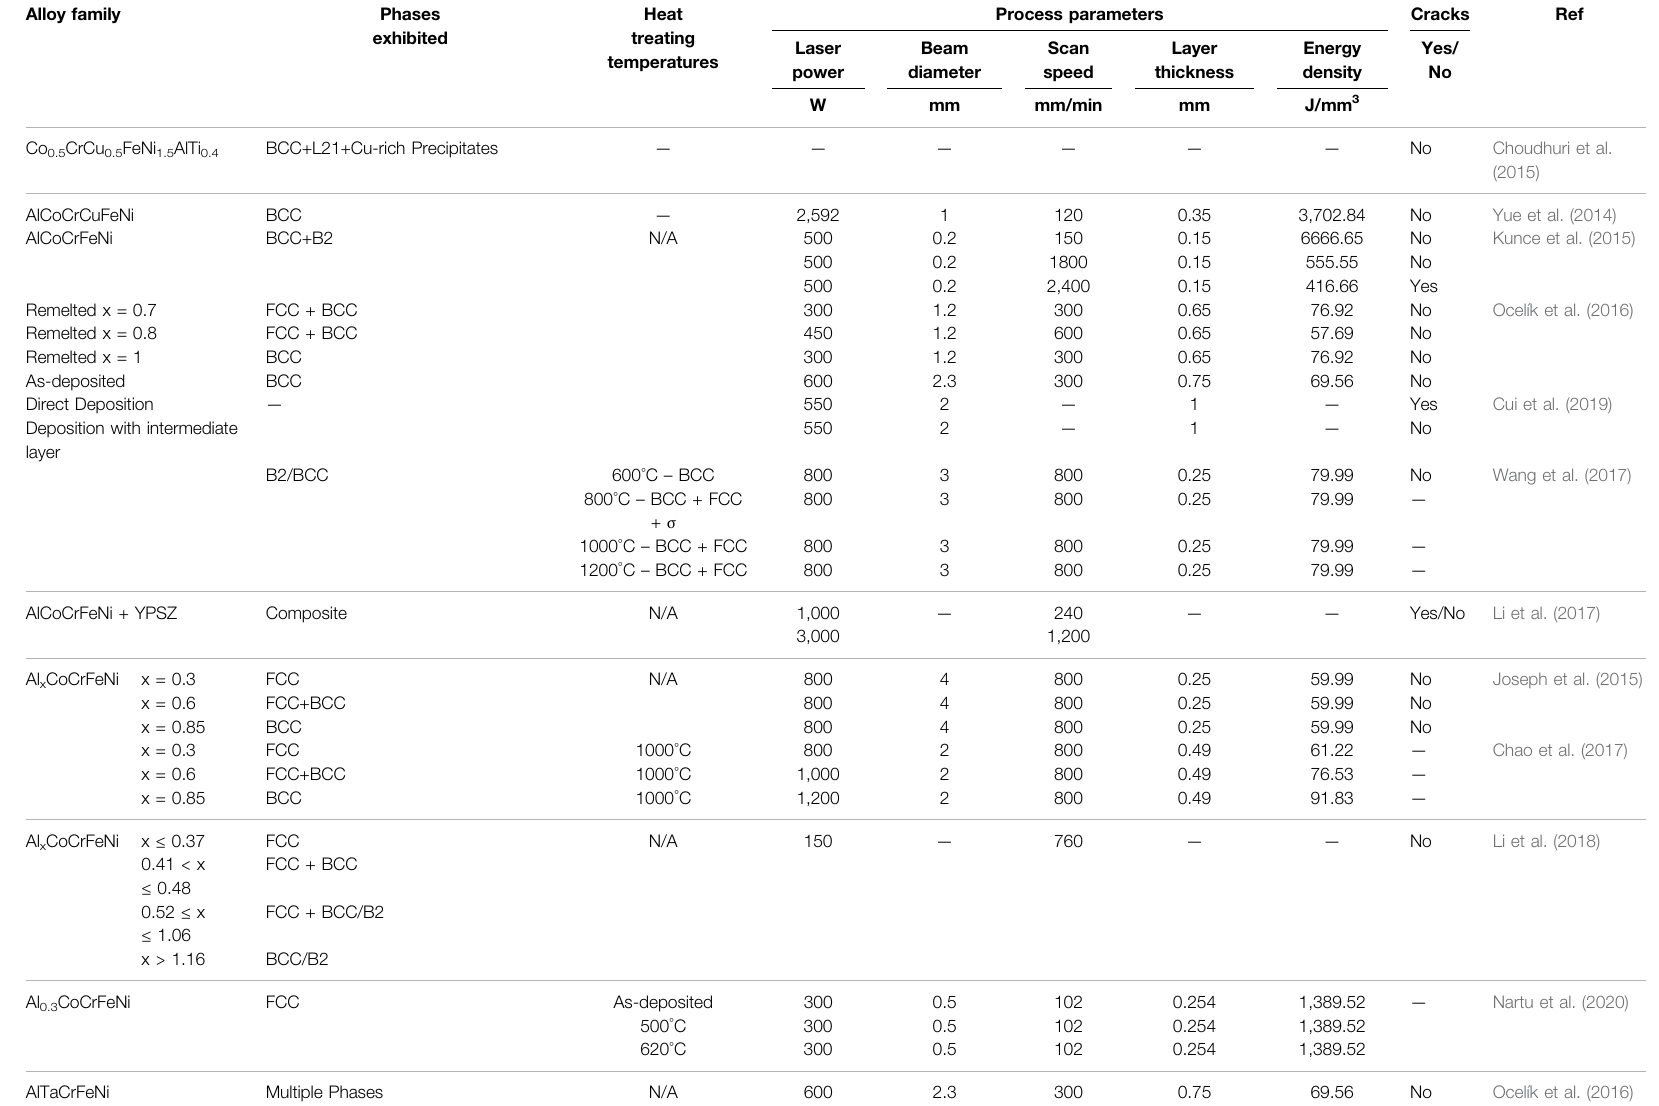
TABLE 1 | Processing parameters and their associated energy densities for various additively manufactured MPEAs. Alloy